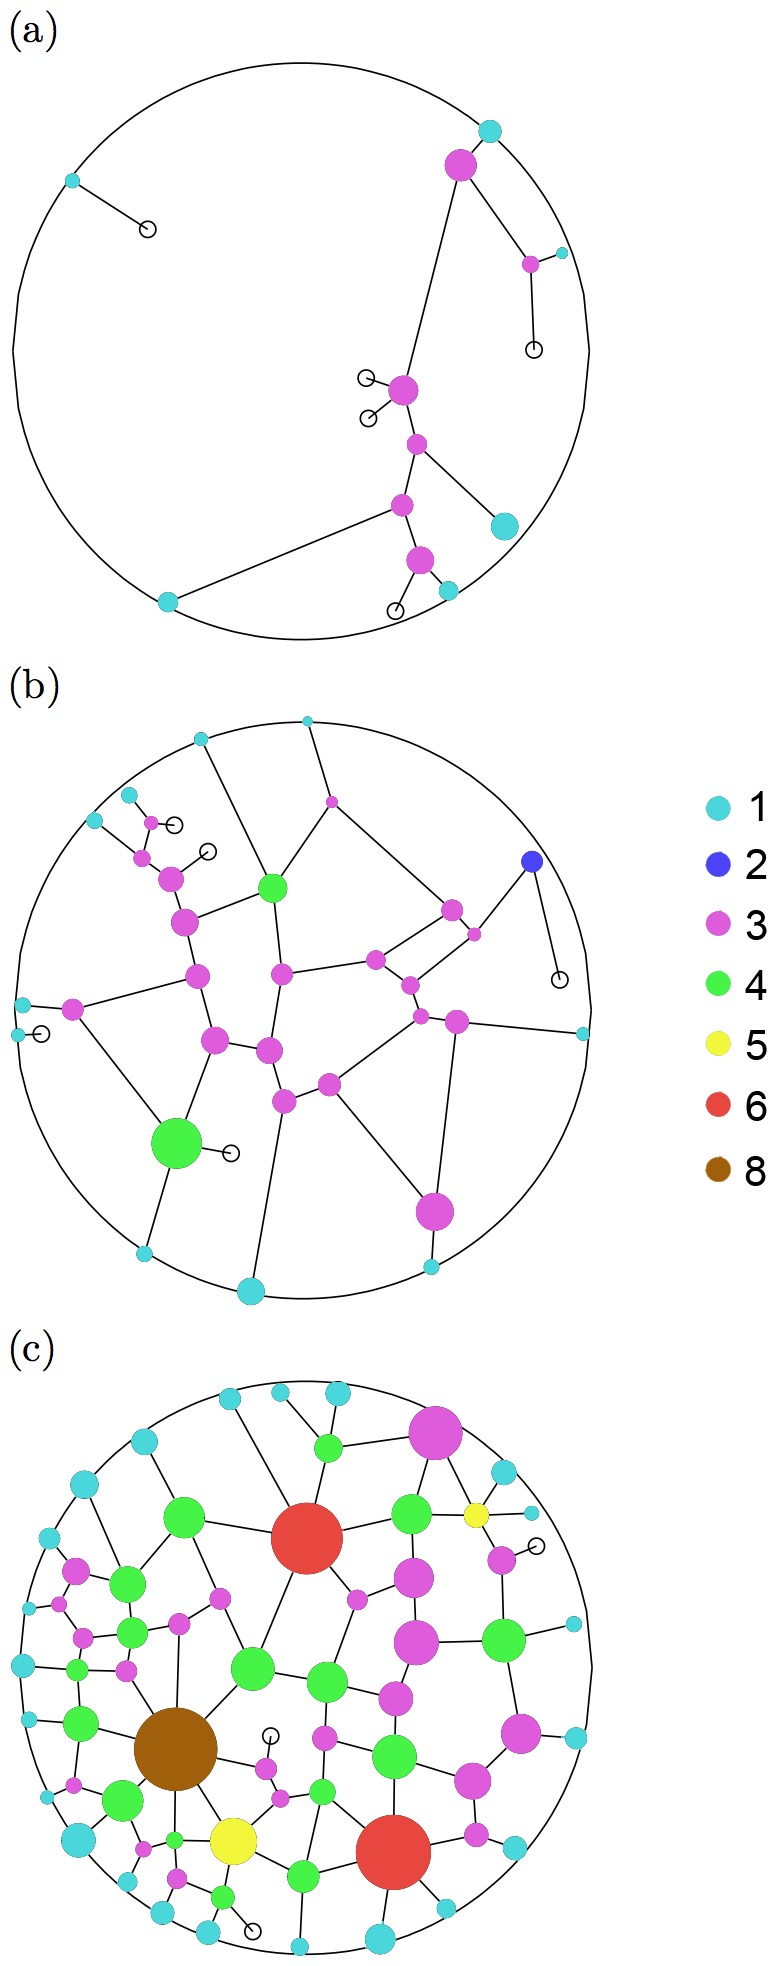
Examples of experimental networks dug by the ants in 72 hours depending on the number of workers (a) , (b) , (c) .The corresponding values of the meshedness  are respectively 0.0, 0.092 and 0.194.